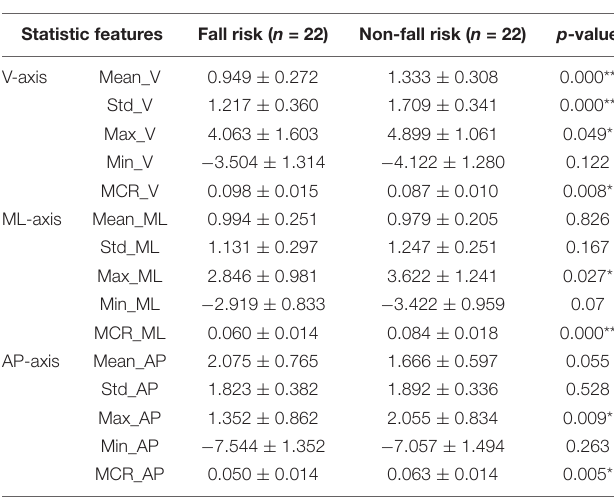
TABLE 2 | Statistical features of TUG data for subjects.